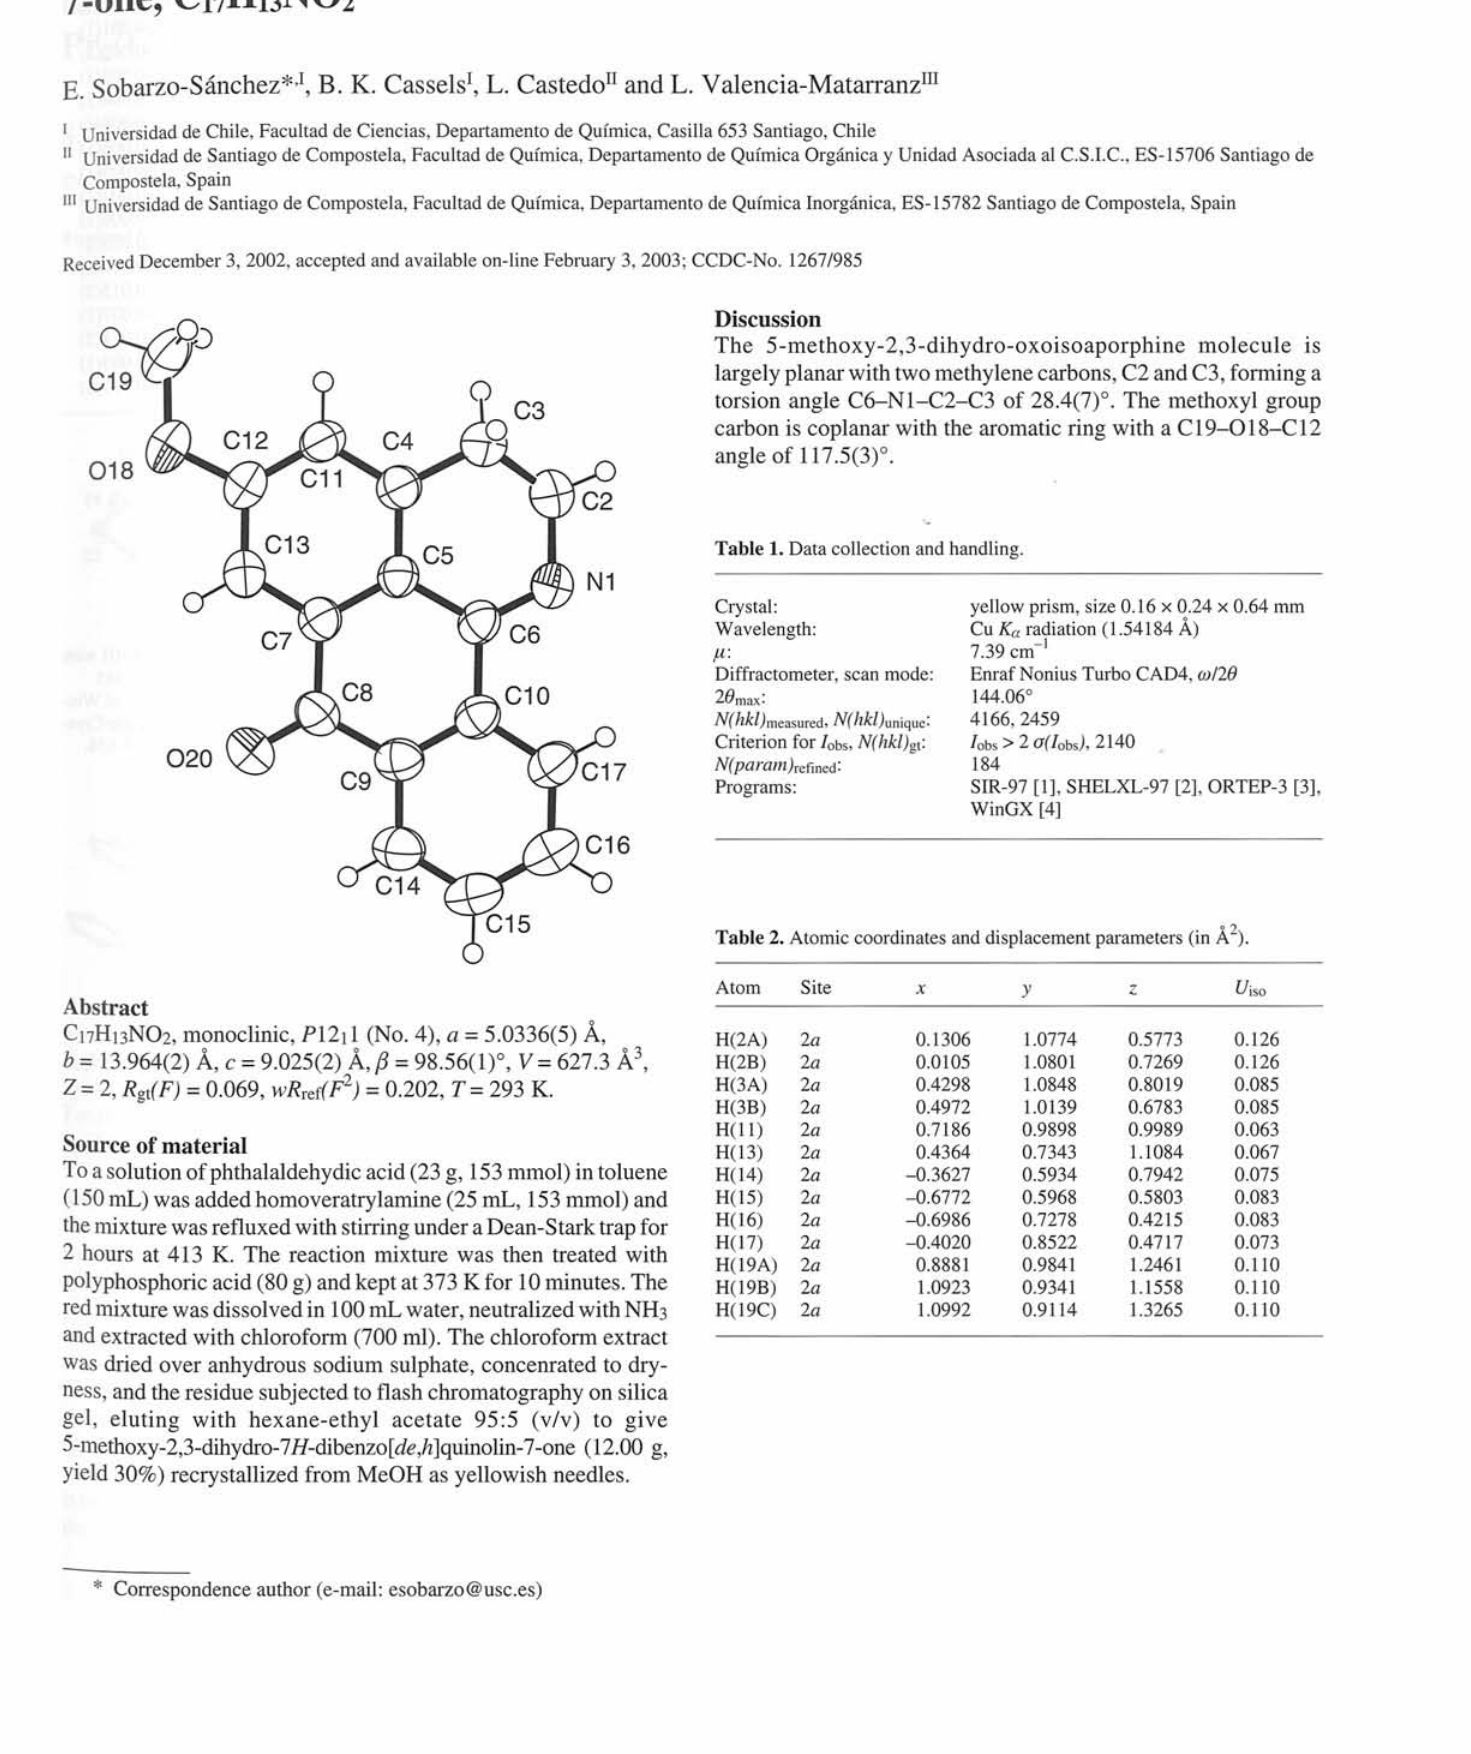
Table 1. Data collection and handling.